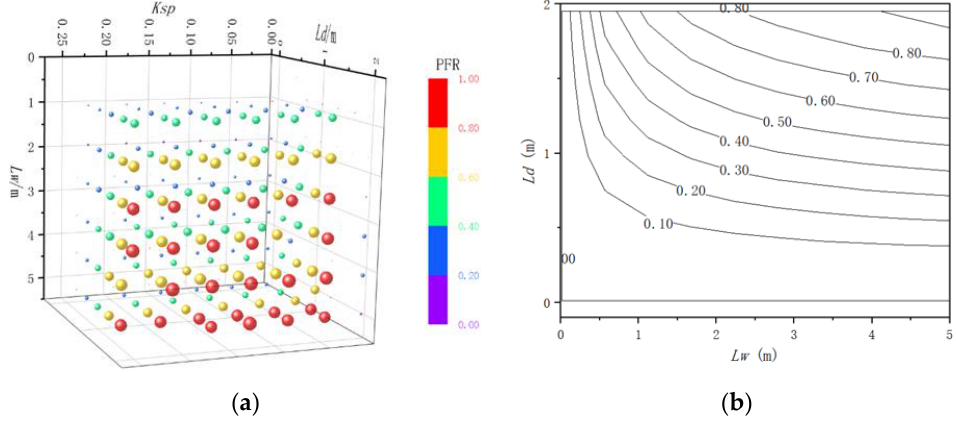
Figure 4. Peak flow reduction rates (PFR) of an off-line ditch-pond system under different com- binations of L d , L w , and K sp . ( a ) Three-parameter combinations; ( b ) Two-parameter combinations ( K sp = 0.05).